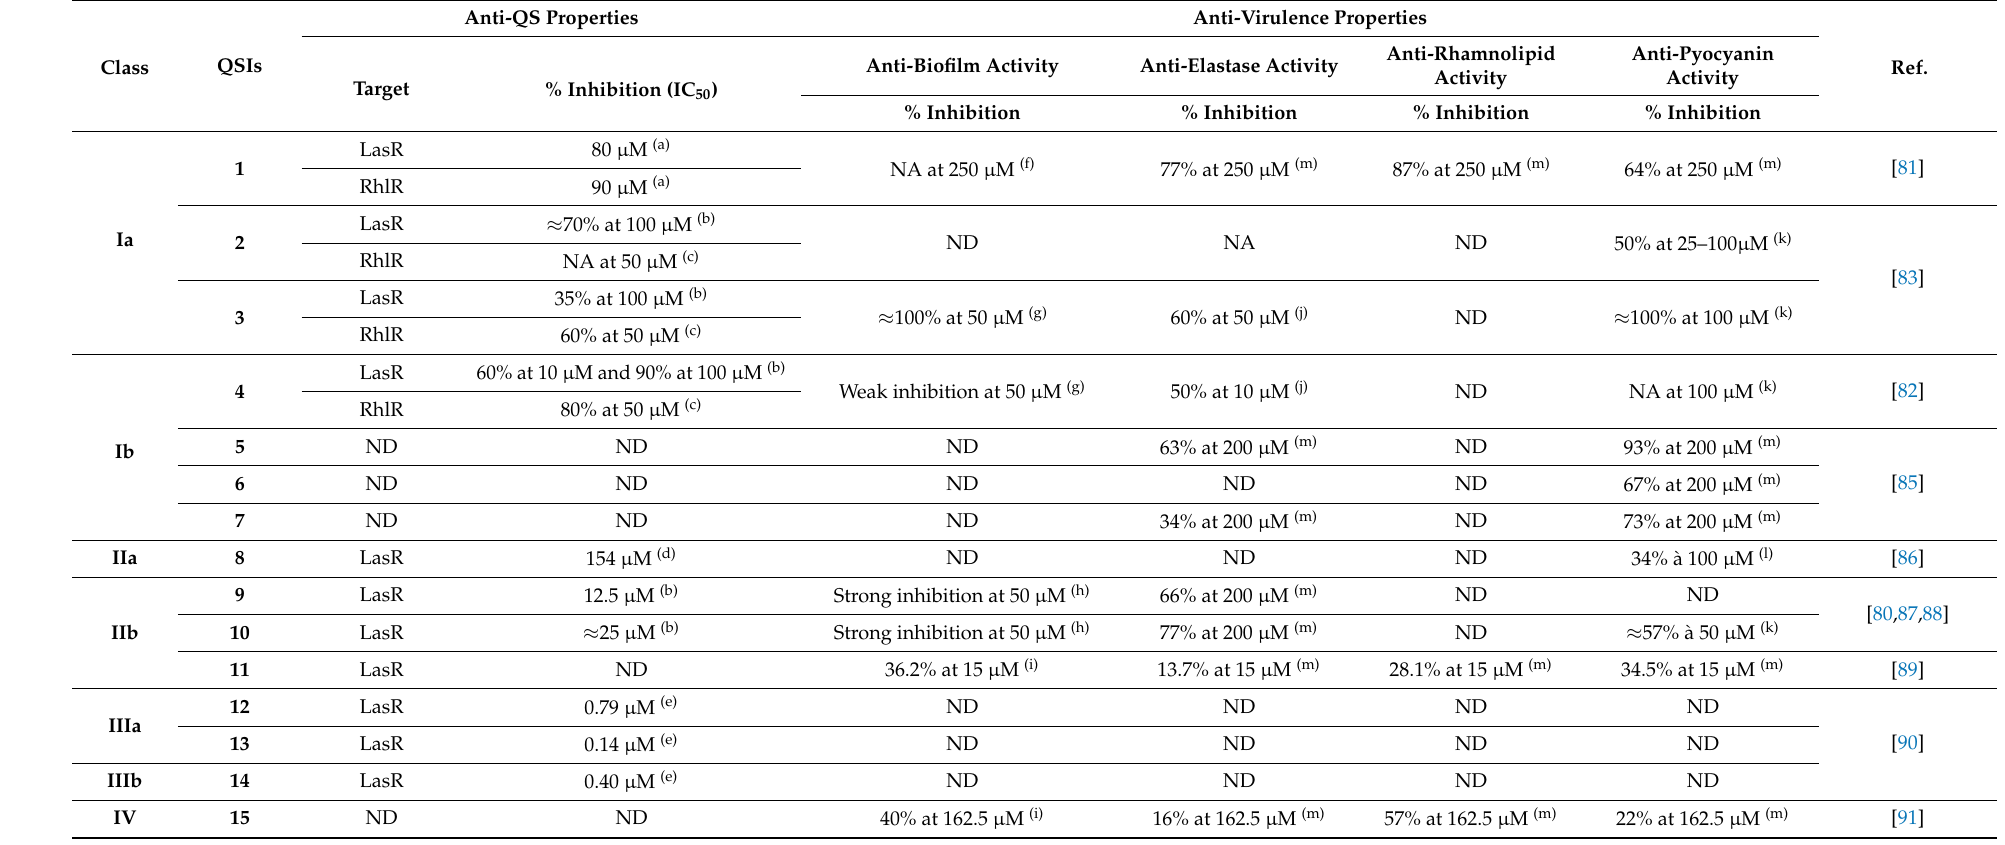
Table 1. Anti-QS and anti-virulence properties of AHL autoinducer analog